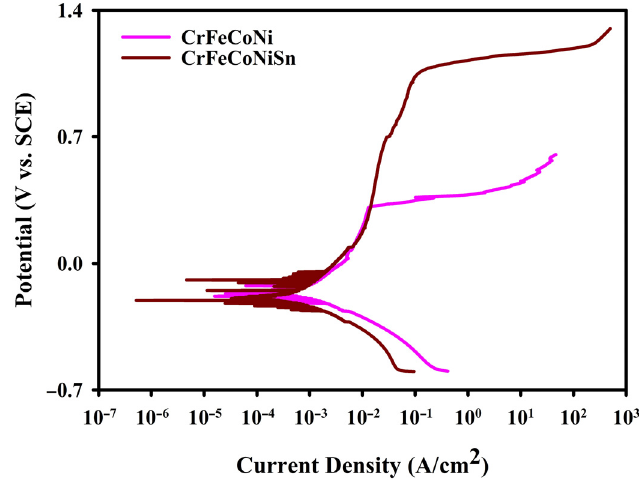
Figure 5. The potentiodynamic curves of CrFeCoNi and CrFeCoNiSn alloys in 0.6 M NaCl solution at ambient temperature. Table 3. The corrosion parameters, obtained via PC analysis of CrFeCoNi and CrFeCoNiSn alloys in 0.6 M NaCl solution at ambient temperature.